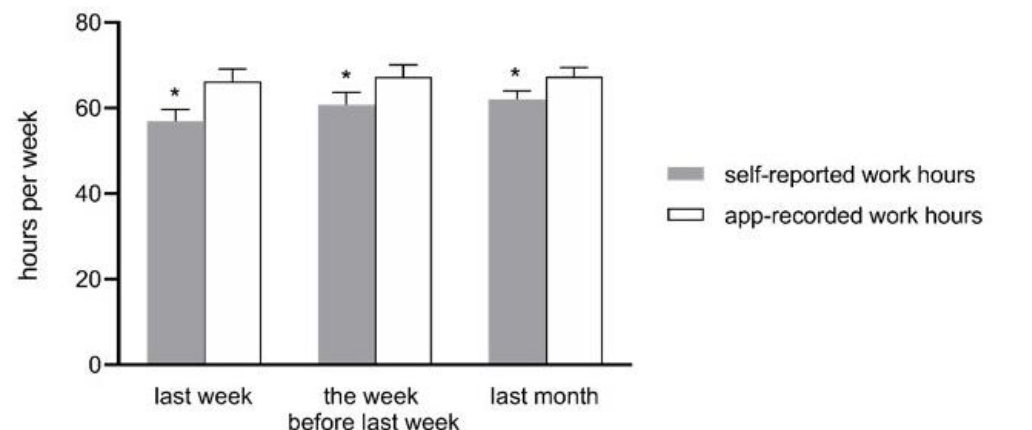
Figure 1. The bar graph compares self-reported work hours and app-recorded work hours at three time points in the past. The solid grey bar represents physicians’ self-reported weekly work hours, and the white bar represents the weekly work hours recorded by the “Staff Hours” app. * The asterisks indicate that self-reported work hours and app-recorded work hours had statistically significant differences. When asked to recall their work hours last month, physicians reported working for an average of 60.24 h per week, whereas the app recorded 66.94 h per week. In other words, physicians’ self-reported work hours showed a 11.5 – 12.0% reduction compared to their app-recorded work hours. In terms of work hours during the previous week, physicians underestimated their work hours by an average of 8.97 ± 8.60 h. Similarly, they underestimated their work hours the week before last week by an average of 6.48 ± 8.29 h. Physicians who worked for more hours underestimated their work hours to a greater extent compared to those who worked for fewer hours (r = − 0.410, p = 0.013). The proportion of days in which physicians could not accurate recall their work hours increased as they tried to recall a more distant time in the past (r = 0.489, p = 0.002).